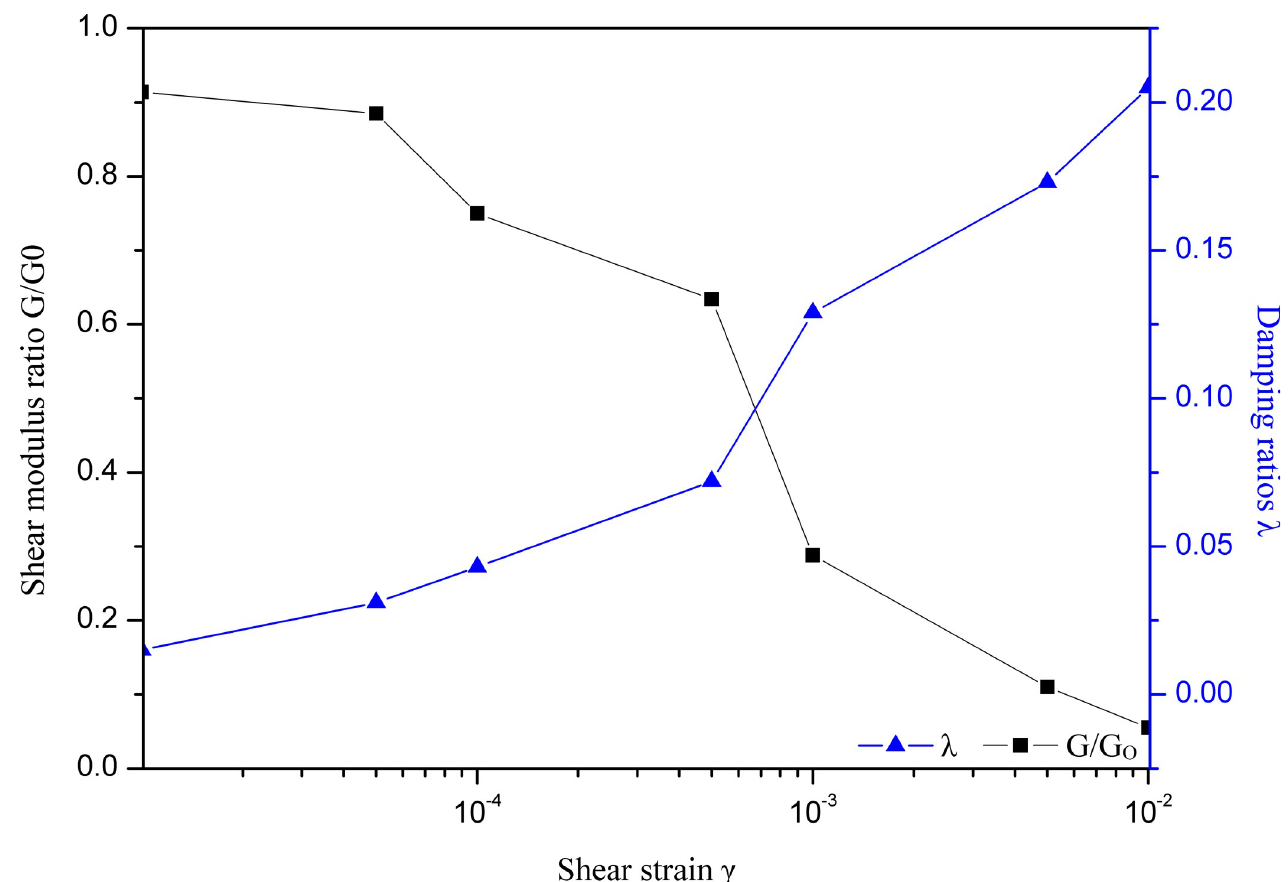
Fig 2. The strain dependent shear modulus ratio and damping ratio for